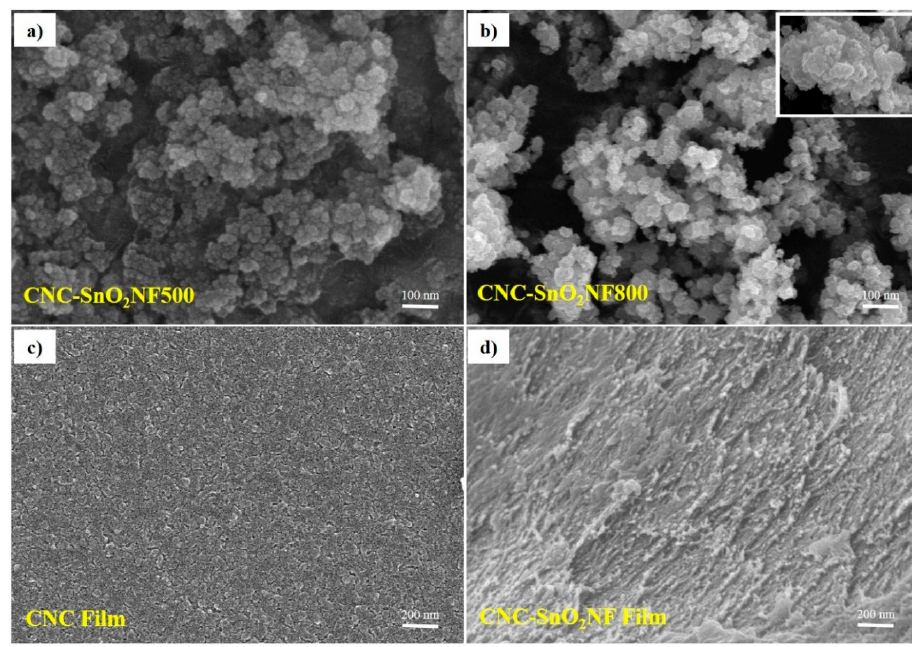
Figure 2. SEM images of ( a ) CNC–SnO 2 NF500, ( b ) CNC–SnO 2 NF800, ( c ) CNC, and ( d ) CNC–SnO 2 NF Film.